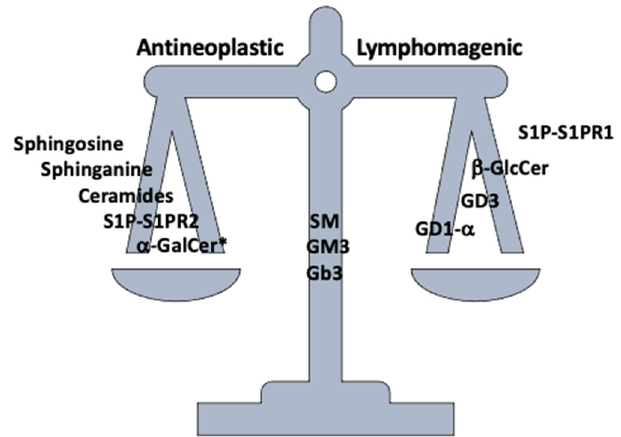
Figure 2. Summary of antineoplastic vs lymphomagenic sphingolipids. * Synthetic; S1P: Sphingosine-1-Phosphate; S1PR-2: Sphingosine-1-Phosphate Receptor 2; α -GalCer: α -galactosylceramide; SM: sphingomyelin; β -GlcCer: β -glucosylceramide; GM3: monosialodihexosylganglioside; Gb3: globotriaosylceramide.